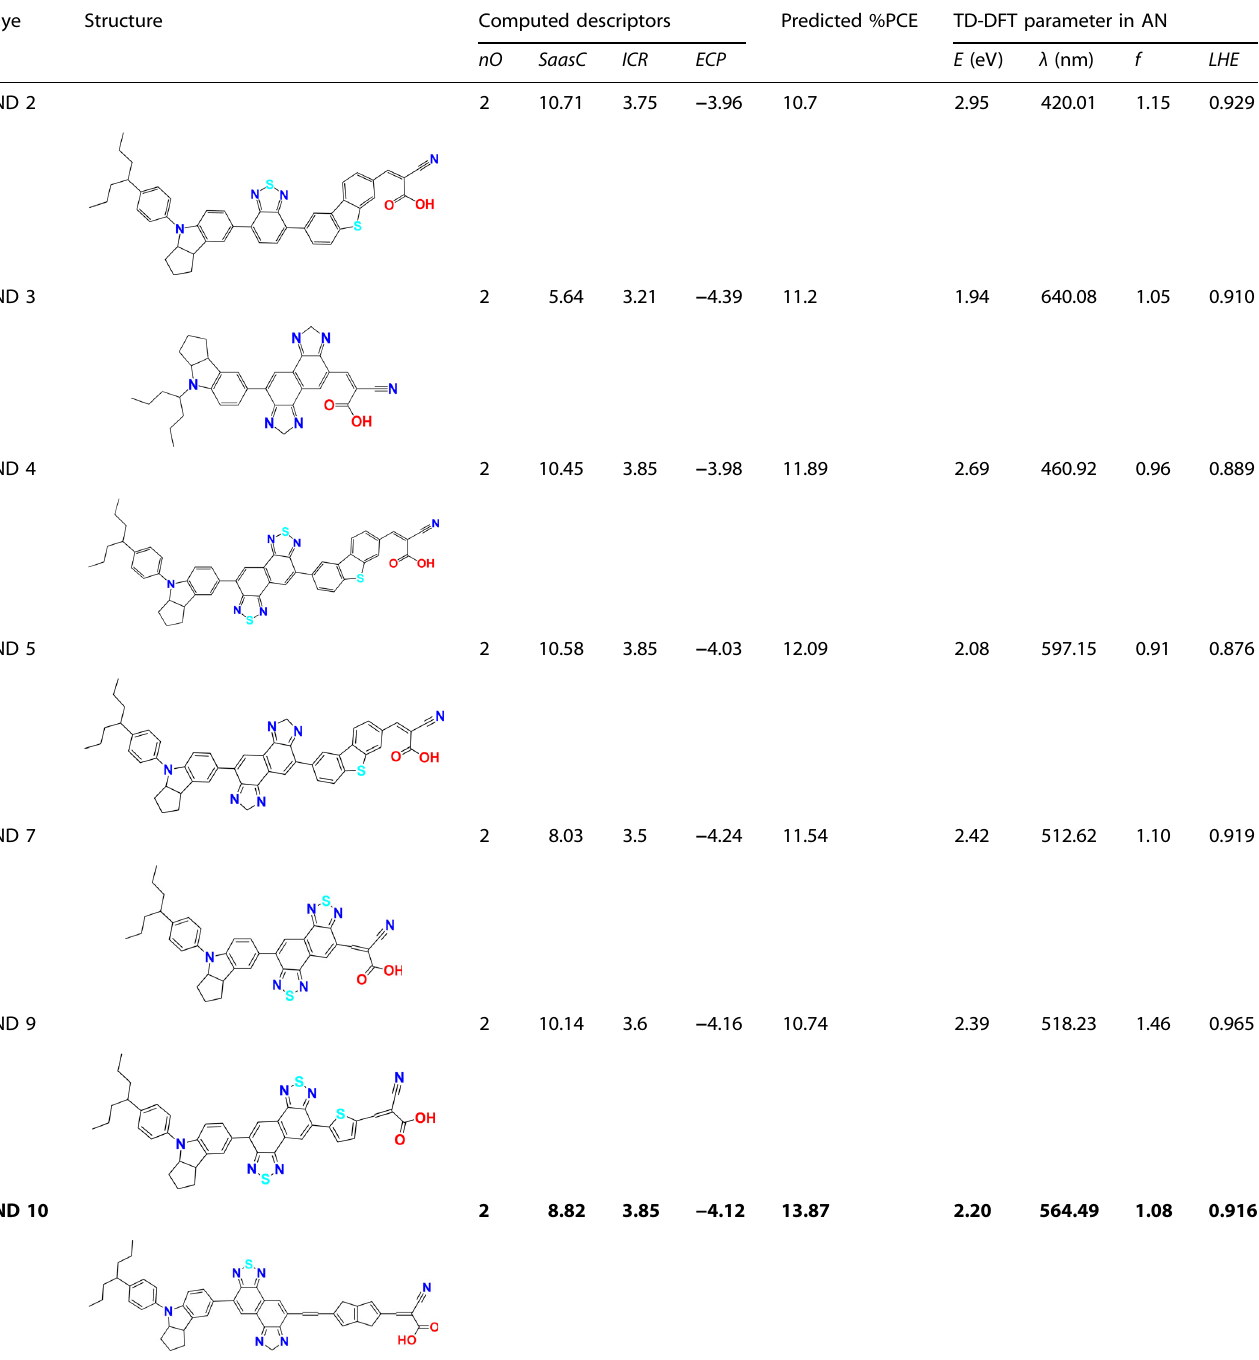
Table 4. Calculated descriptor, predicted %PCE and TD-DFT parameter [excitation energy ( E ), wavelength ( λ ), oscillator strengths ( f ), and light harvesting ef fi ciency (LHE) in acetonitrile (AN) media] of the designed indoline